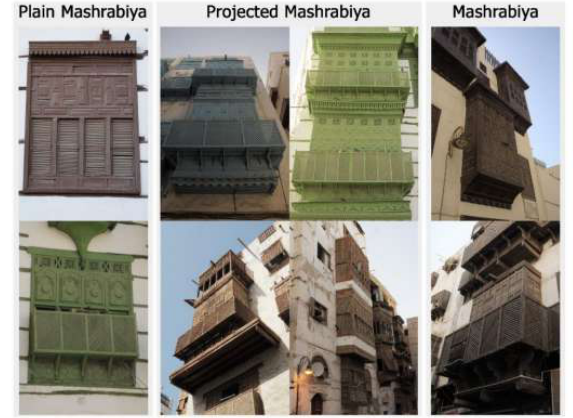
Figure 5. Different shapes of Mashrabiya in Historic